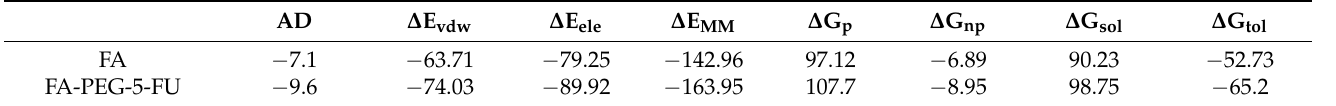
Table 2. Binding energies of FA and